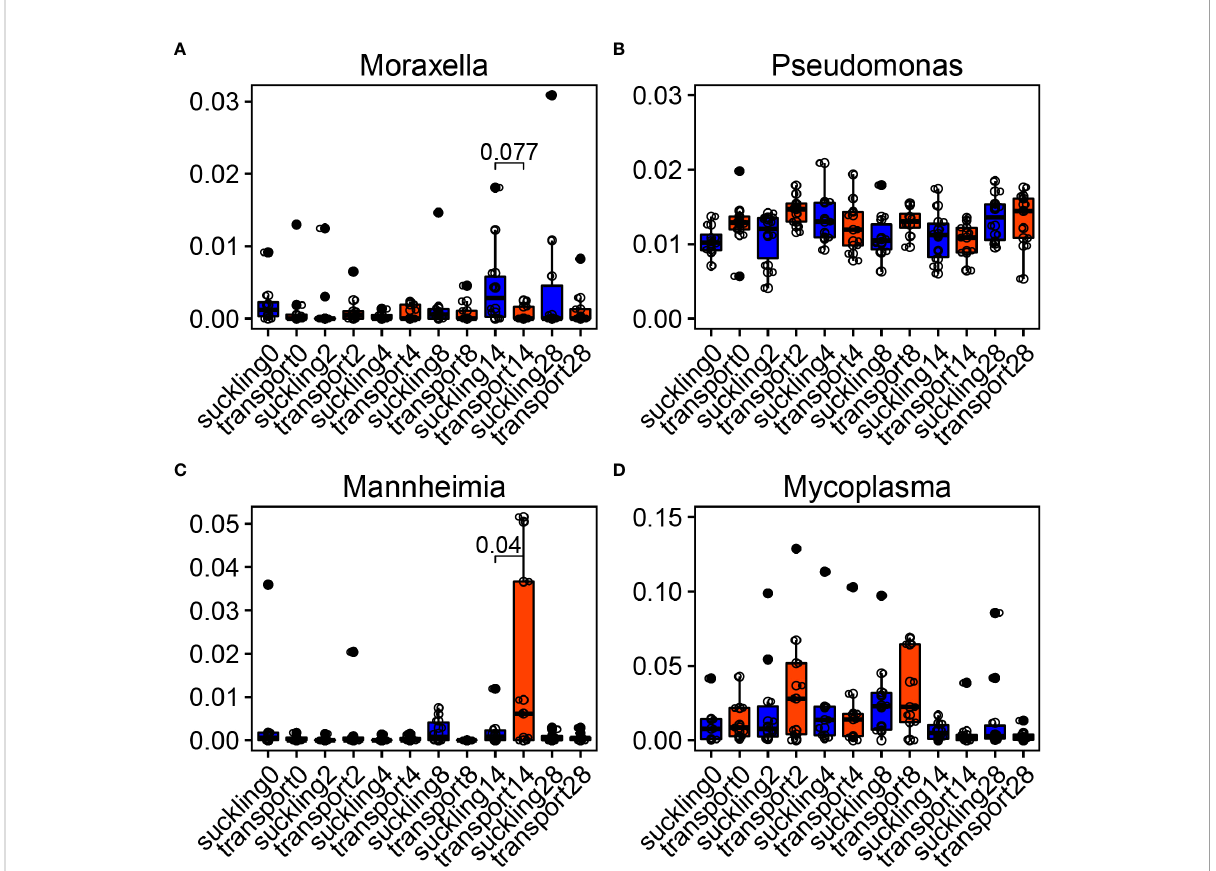
FIGURE 7 Temporal dynamics of bovine respiratory microbiota after weaning + transportation (WT). (A – D) Main bacterial genera changed after WT compared with the control group that stayed with their dams (suckling). Signi fi cances were labeled between suckling and WT at the time when they were statistically